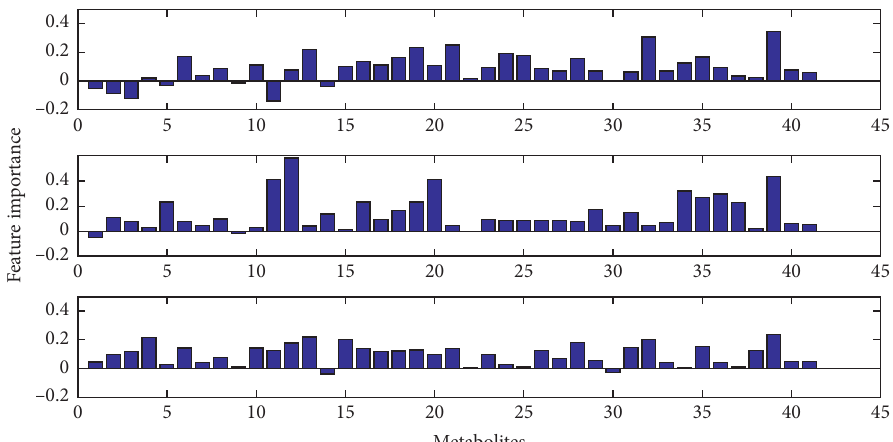
Figure 4: The variable importance of metabolites. (a) Healthy control vs. early- and middle-stage groups, (b) healthy control vs. advanced- stage group, and (c) early- and middle-stage groups vs. advanced stage group.